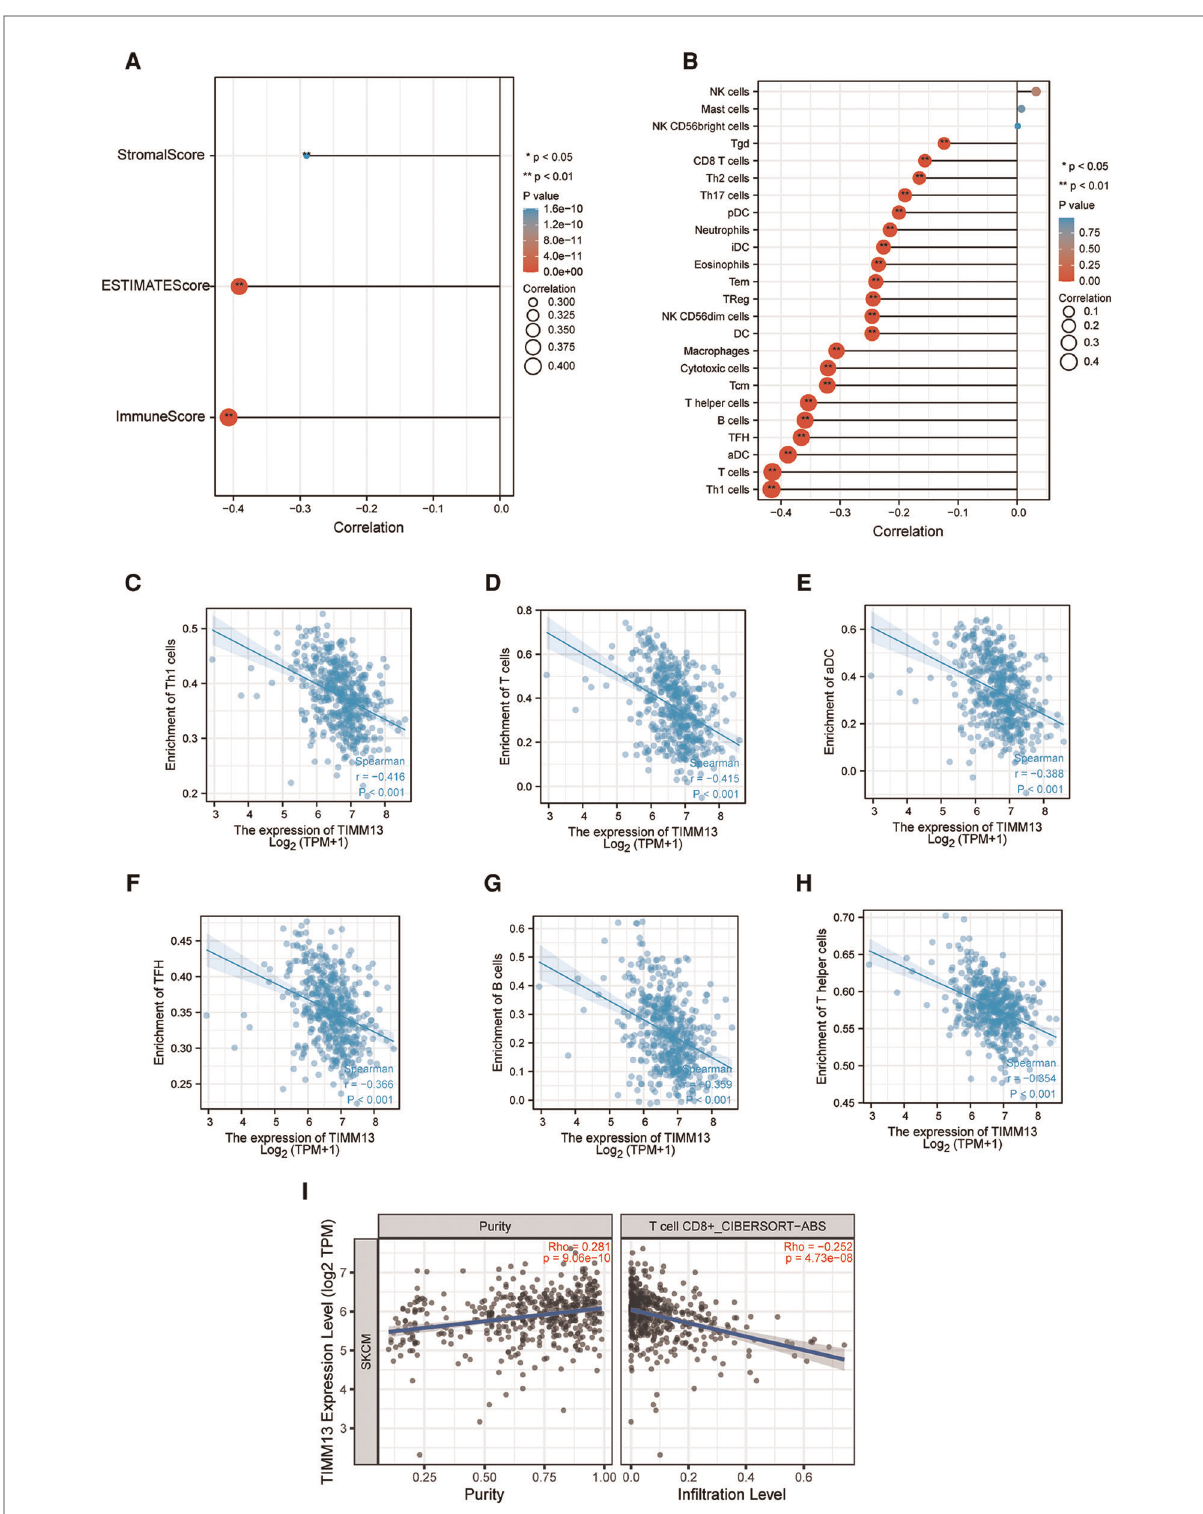
FIGURE 4 Correlation of TIMM13 expression with immune in fi ltration in SKCM. ( A ) Correlation of TIMM13 expression with in fi ltration levels of StomalScore, ESTIMATEScore, and ImmuneScore in SKCM available at Xiantao tool. ( B ) Correlation of TIMM13 expression with in fi ltration levels of immune cells in SKCM available at Xiantao tool. Correlation of ITGAL expression with in fi ltration levels of Th1 cells ( C ), T cells ( D ), aDC ( E ), TFH ( F ), B cells ( G ), and T helper in SKCM ( H ). ( I ) Correlation between the expression of TIMM13 and the abundance of TILs in SKCM validation at TIMER